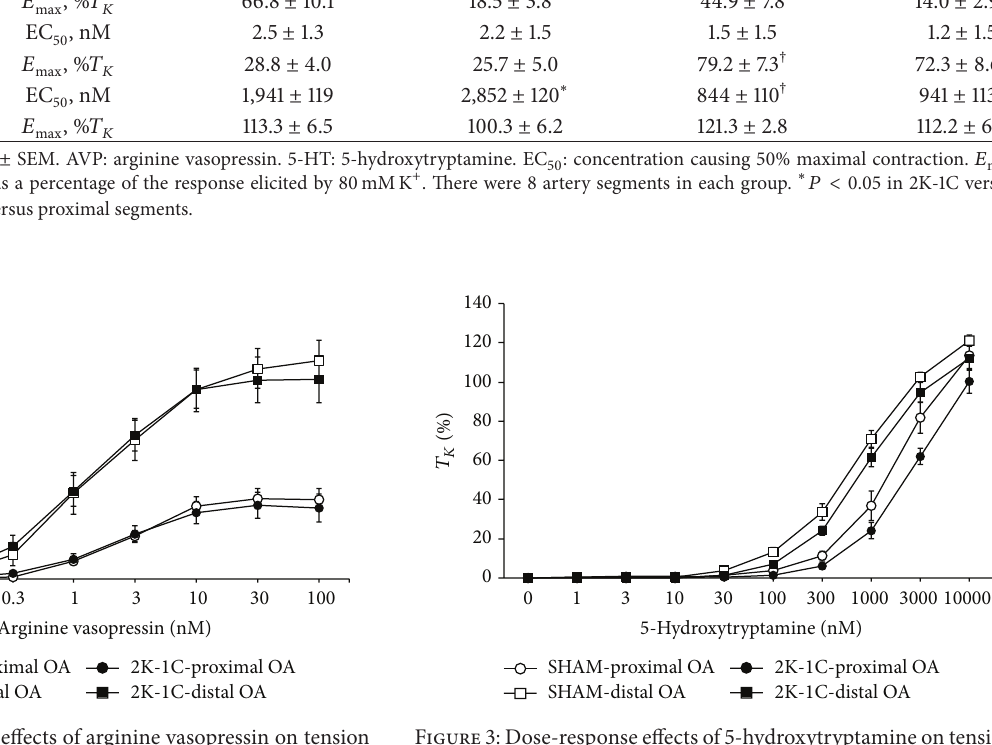
Table 2: Contractile effects of agonists on proximal and distal segments of the occipital artery. Proximal segments Distal segments Agonist Parameter SHAM 2K-1C SHAM 2K-1C EC , nM 6.5 ± 1.3 6.8 ± 1.5 50 Angiotensin II 𝑇 ± 10.1 𝐸 max , % 𝐾 66.8